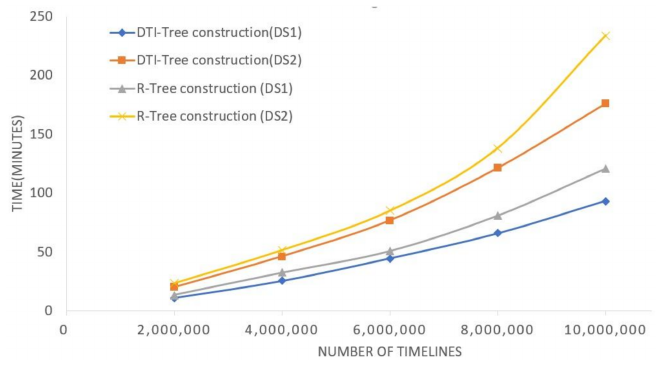
Figure 13. Construction